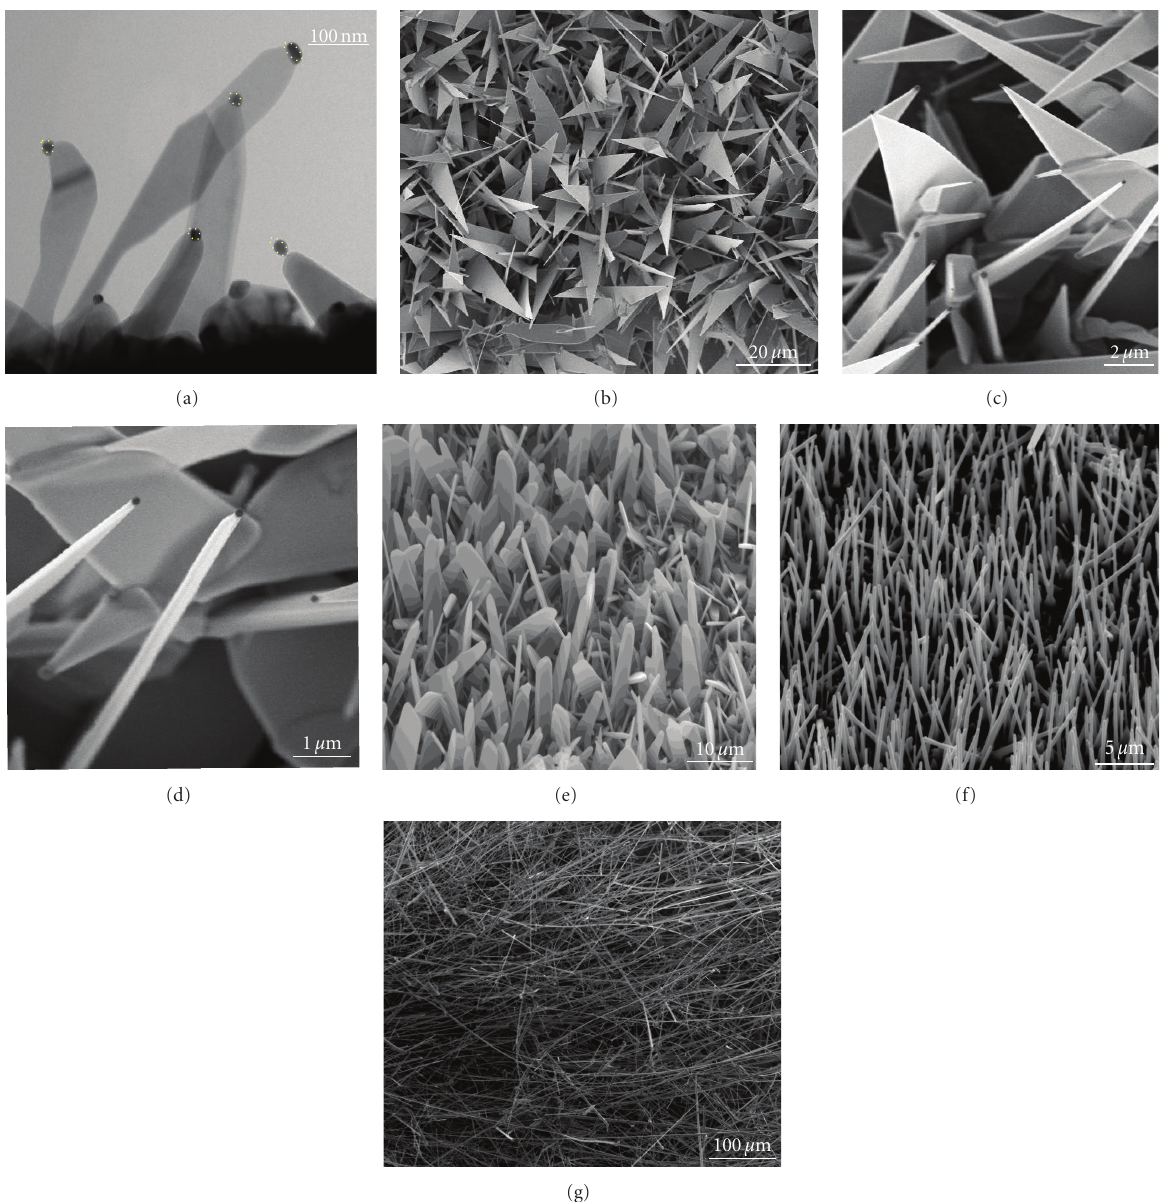
Figure 1: (a)–(d) show nanostructures grown by conventional VLS approach, (a) transmission electron microscope (TEM) image of ZnO nanorods with Au NPs on their heads (inside dotted circles); (b), (c), and (d) scanning electron microscopy (SEM) images ZnO nanoSails at di ff erent magnifications. The presence of Au NP on the top of nanoSail can be clearly seen in 1D (inside dotted circles). (e) and (f) show the structures grown by modified VLS approach [24] without any catalytic NPs: (e) ZnO nanomast structures, (f) ZnO nanorods, and (g) tin oxide